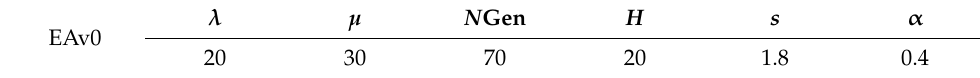
Table 3. The main parameters of